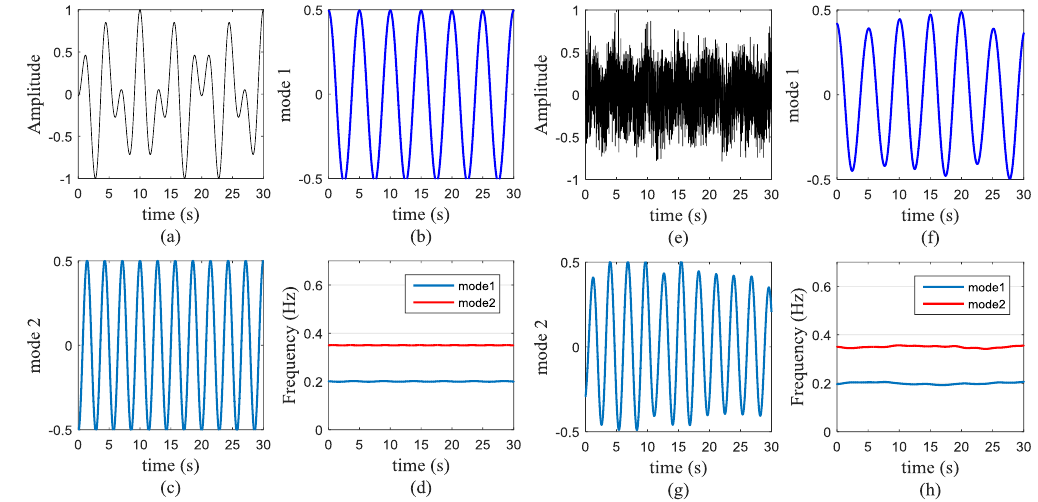
Figure 3. Simulated respiration signals and separation results. ( a ) Simulated signal, ( b ) and ( c ) two modes decompose by Variational Mode Decomposition (VMD) based algorithm; ( d ) time-varying respiration signals; ( e ) Simulated signal with − 10 dB SNR, ( f ) and ( g ) two modes decompose by VMD based algorithm; ( h ) time-varying respiration